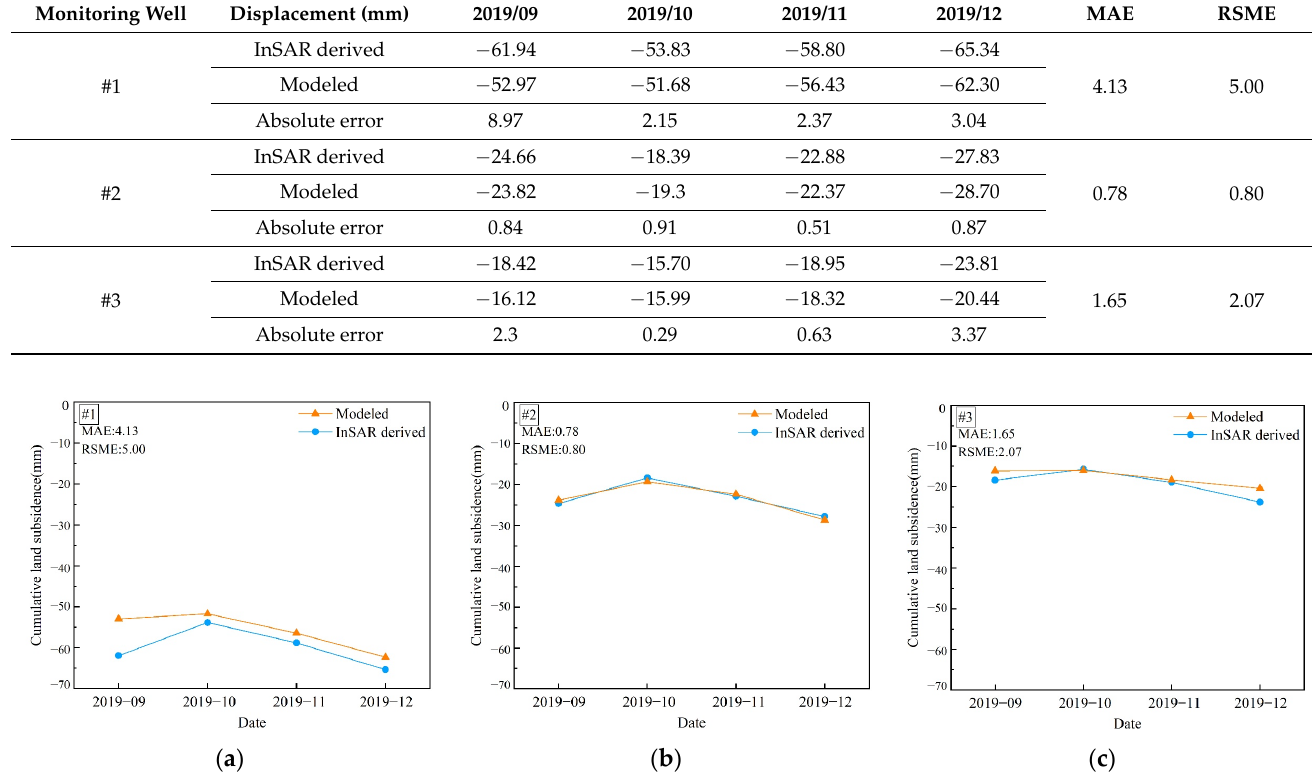
Figure 14. InSAR and simulated values for each monitoring well: ( a ) well #1, ( b ) well #2 and ( c ) well